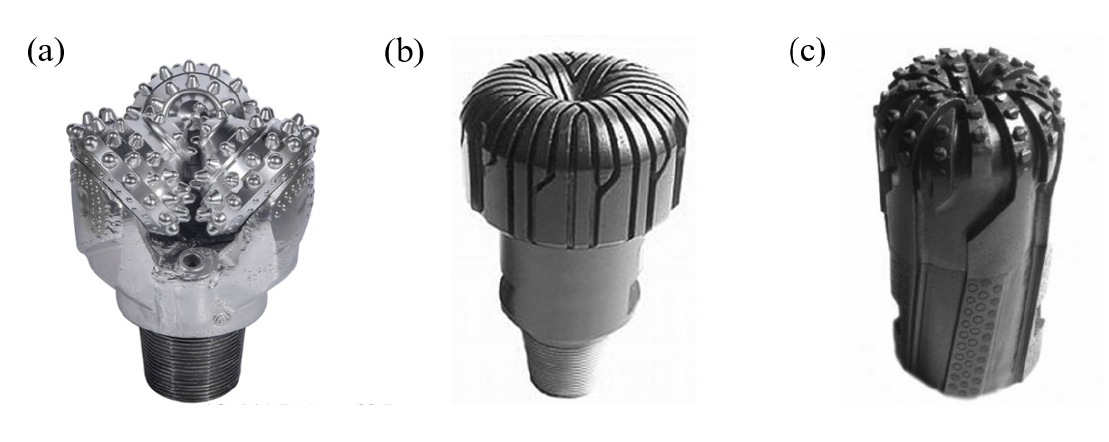
Figure 2. ( a ) tricone roller drilling bit; ( b ) impregnated drilling bit; ( c ) dual diameter bit